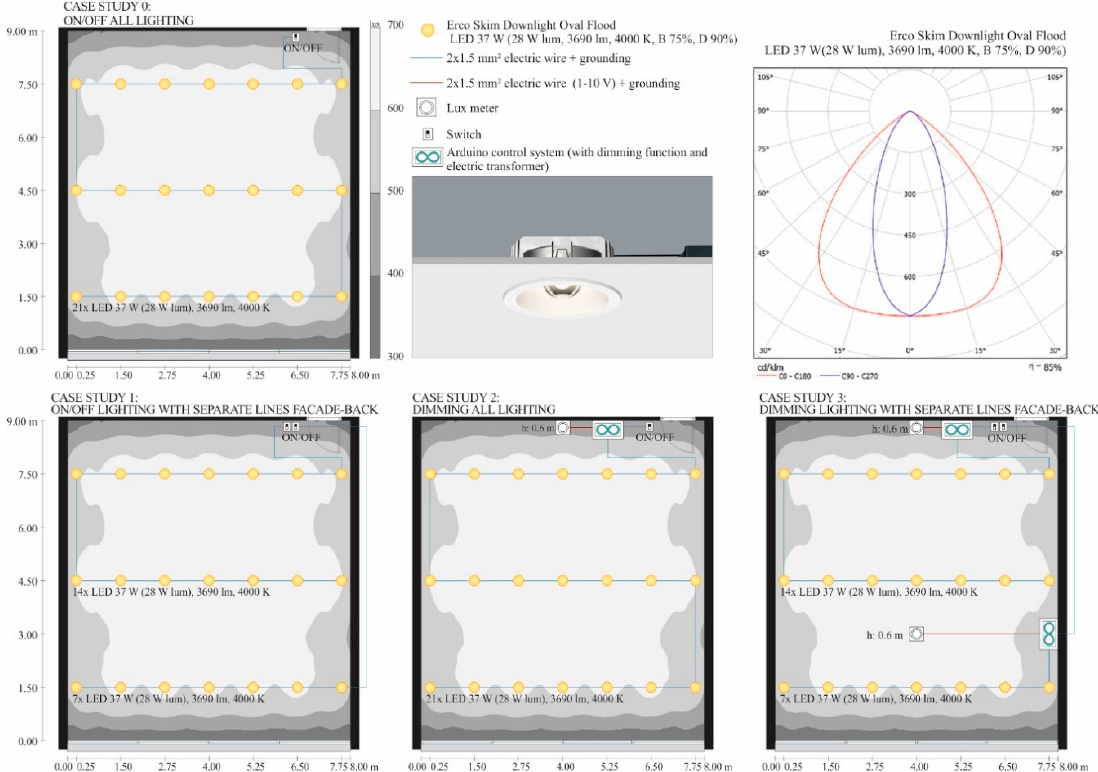
Figure 2. Lighting design of the room model and proposed smart controls.